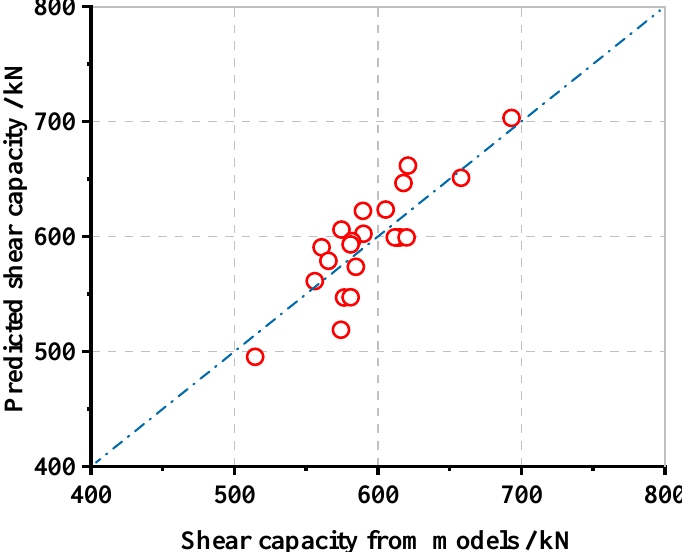
Figure 15. Comparative verification of shear-bearing capacity equations.